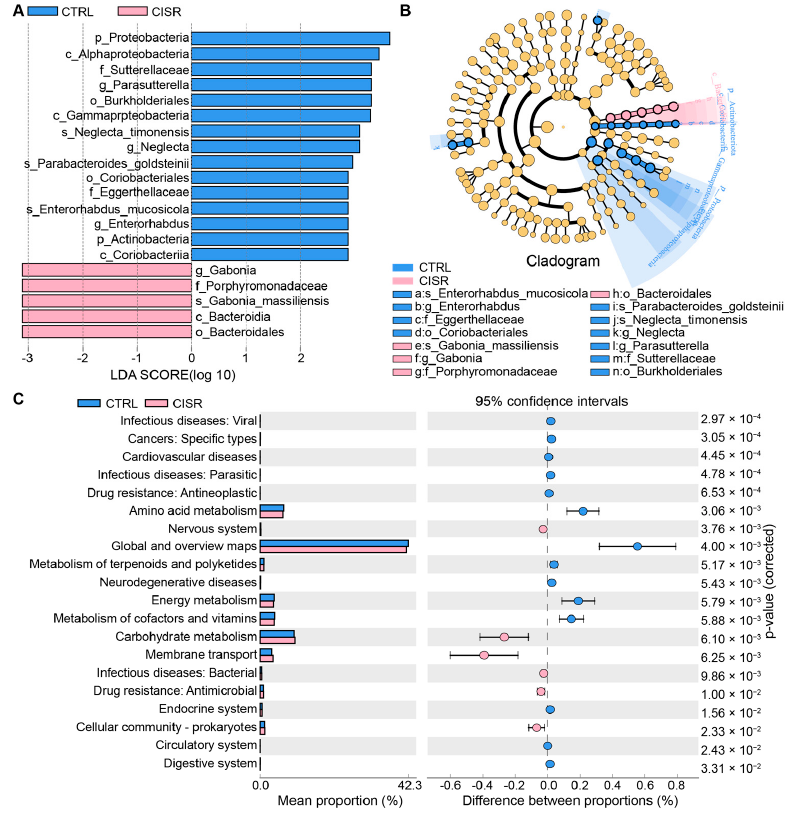
Figure 4. Distinct taxa with greater contributions at different taxonomic levels and the predicted functional changes in the gut microbiota. ( A ) Linear discriminant analysis (LDA) effect size (LEfSe) identified microbial biomarkers from phylum to species levels that discriminate the CTRL and CISR groups. ( B ) Cladogram constructed using the LEfSe method to display the phylogenetic distribution of bacteria that were most highly enriched in the CTRL and CISR groups. Nodes in red and blue indicate the significant taxa. ( C ) The KEGG analysis showed the potential pathways associated with changes in the intestinal microbiota after the CISR treatment ( p <